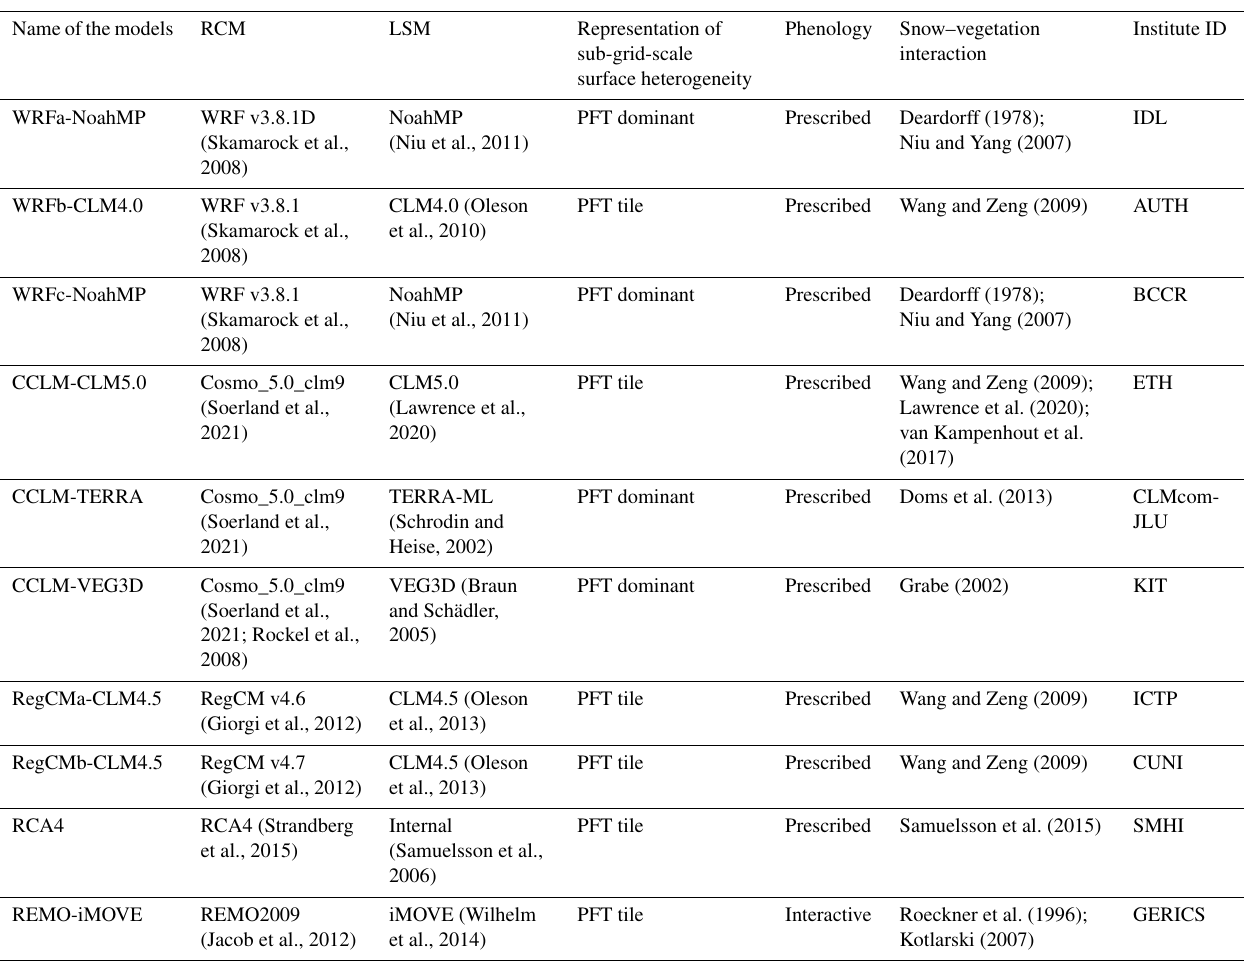
Table 1. Summary of participating regional climate models and their land surface models. Name of the